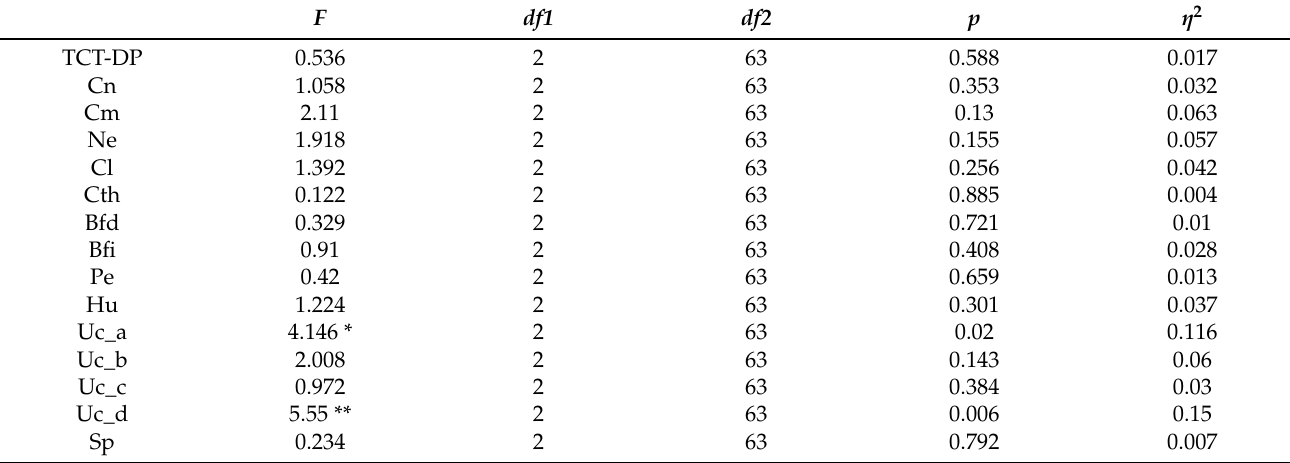
Table A3. Results of variance analysis of the change of TCT-DP.